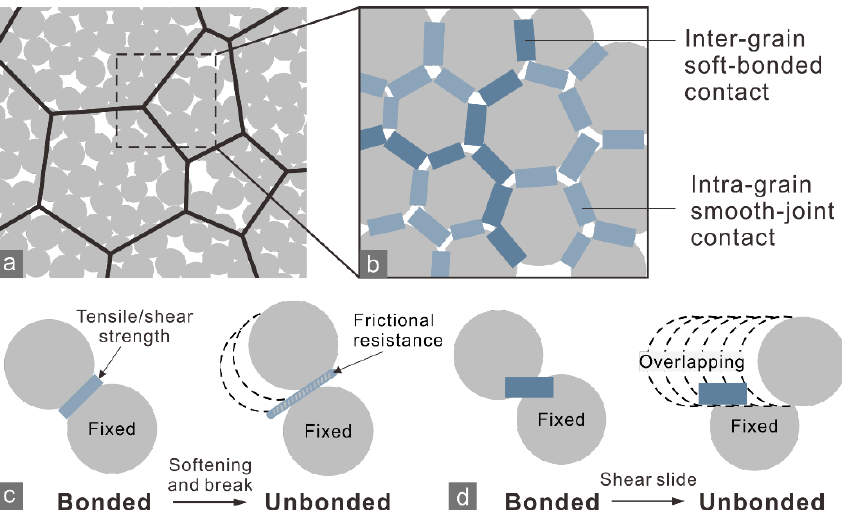
Figure 8. ( a ) Grain-based model for marble and ( b ) the implement of inter-grain soft-bonded and intra-grain smooth-joint contacts. Schematic of bonded and unbonded state for ( c ) soft-bonded and ( d ) smooth-joint contacts. ( b ) is the zoomed-in view of the dashed box in ( a ).